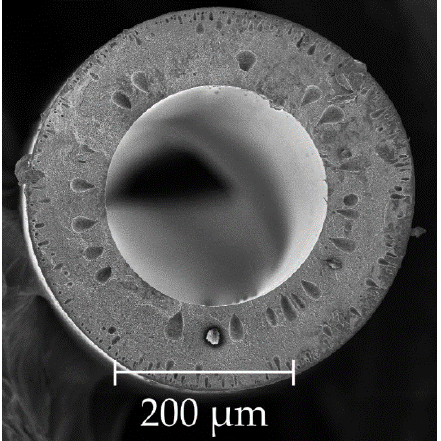
Figure 1. Photo of a hollow fiber [14].